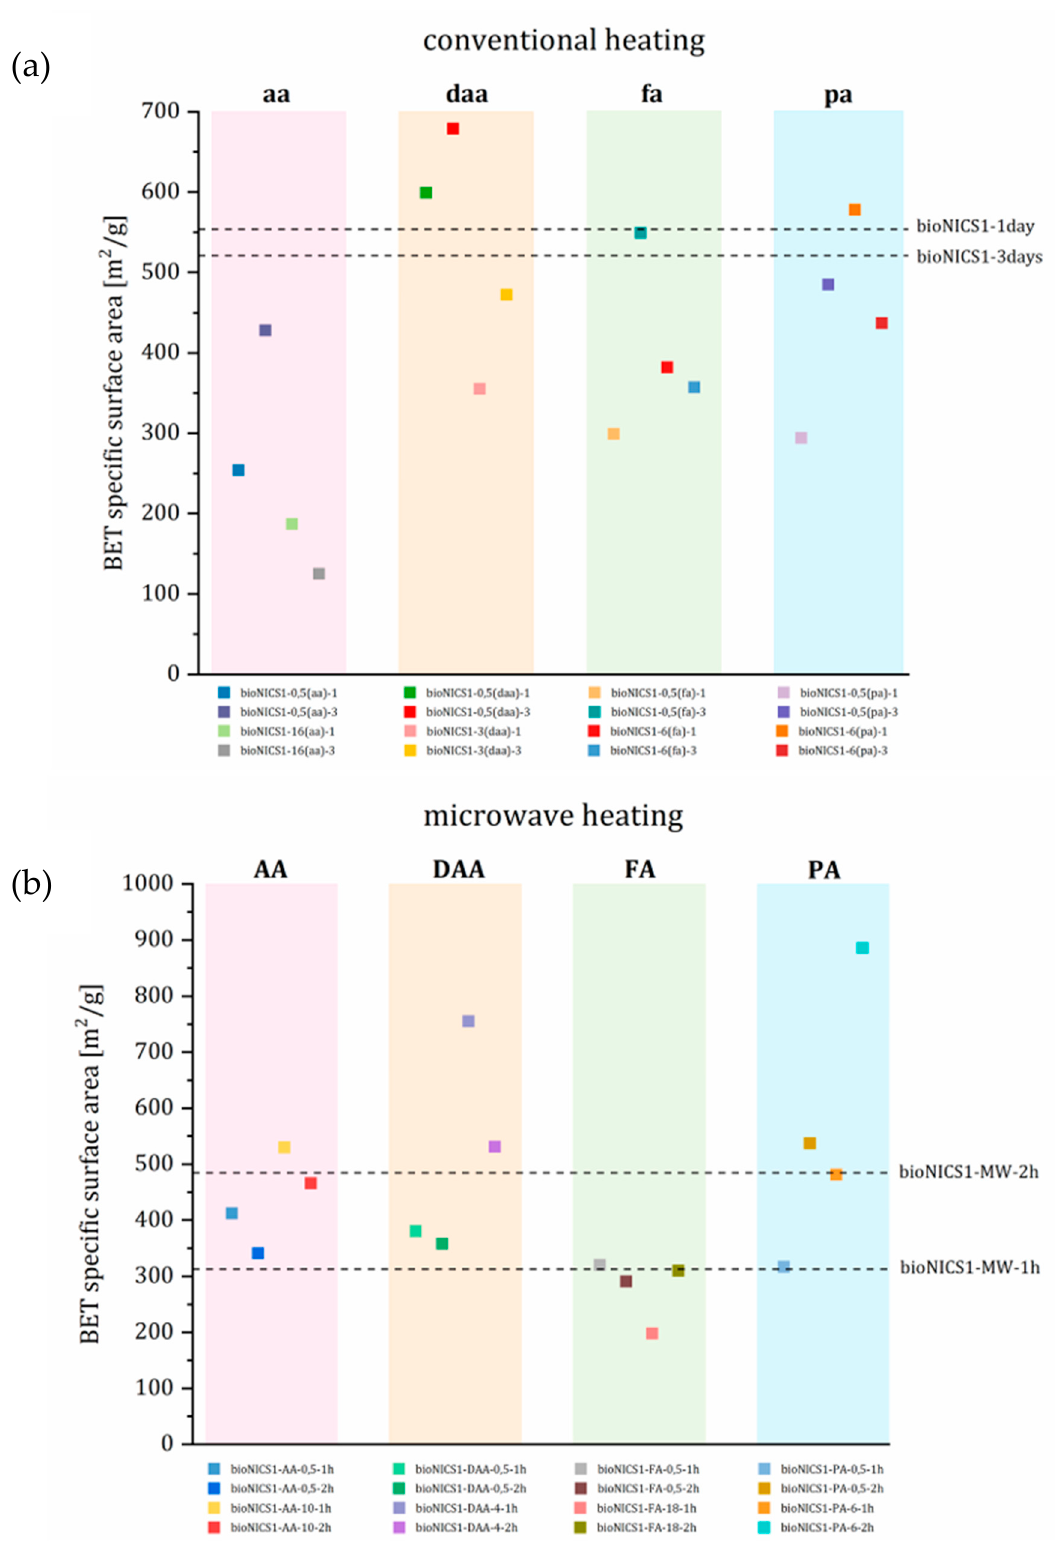
Figure 4. BET surface area of selected materials ( a ) conventional and ( b ) microwave heating arranged according to acid used. Colors of the squares are correspondent to the isotherms and pore size distribution presented in Supplementary. Dotted lines represent the BET value of pristine materials.